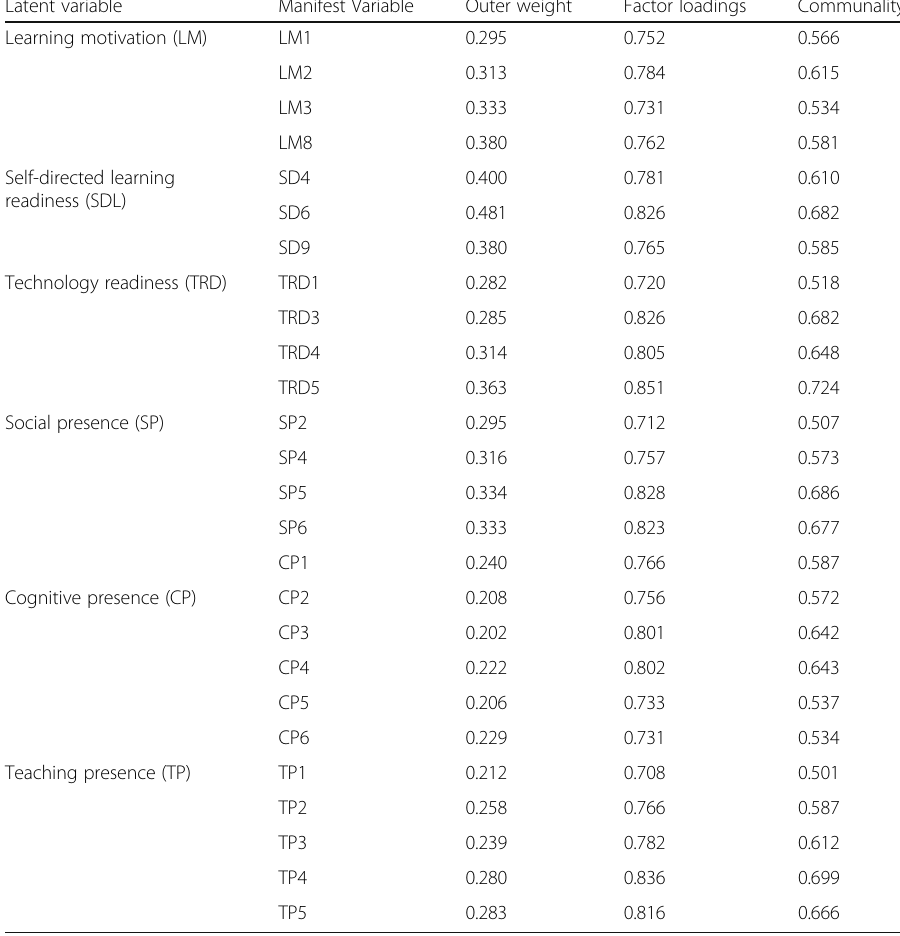
Table 2 The outer model